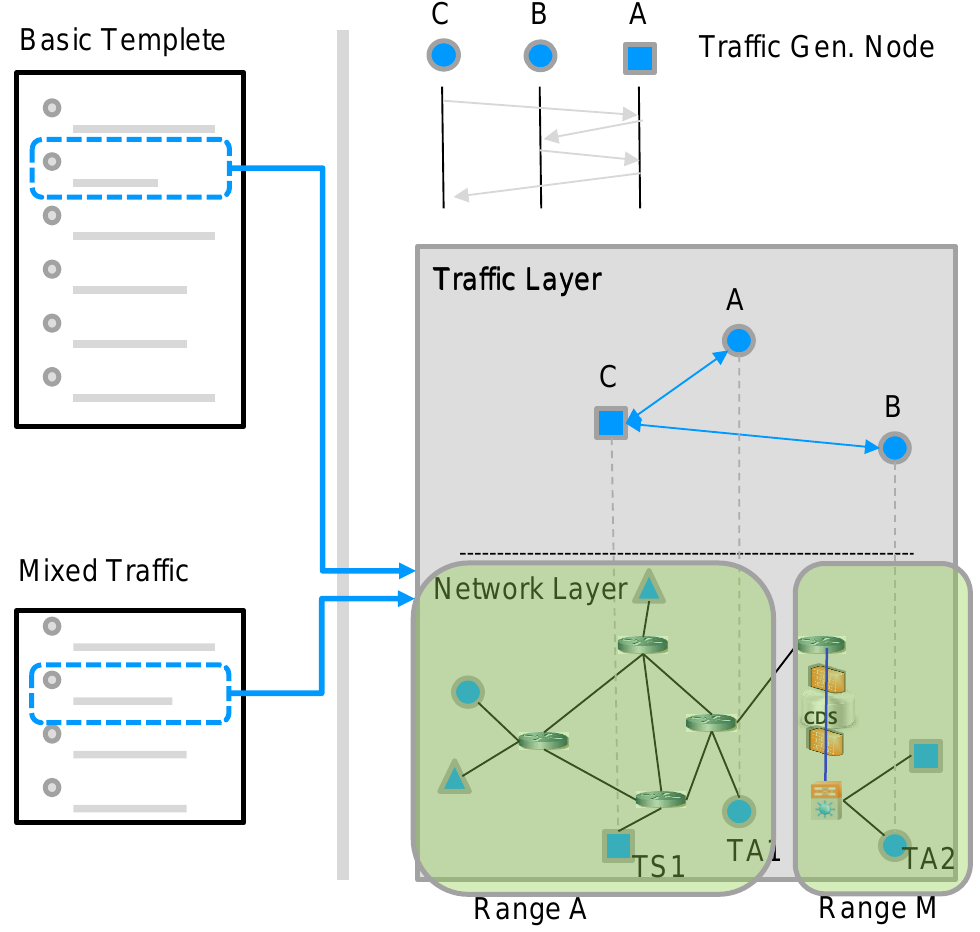
Figure 9. Mapping traffic generation node.